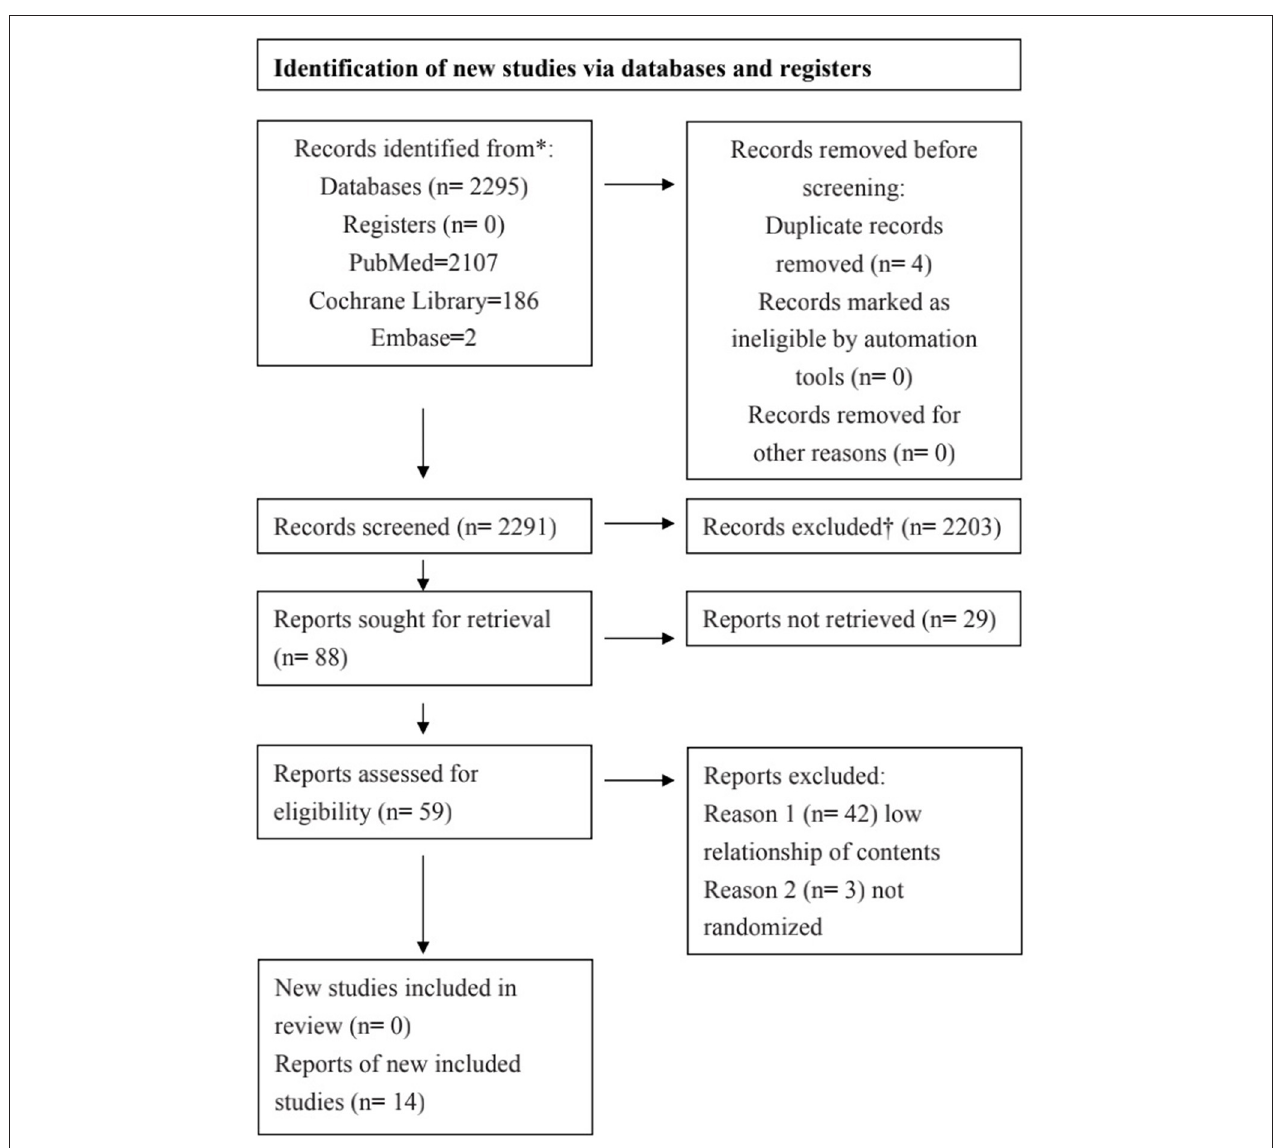
FIGURE 1 | PRISMA (Preferred Reporting Items for Systematic Reviews and Meta-Analyses) flow